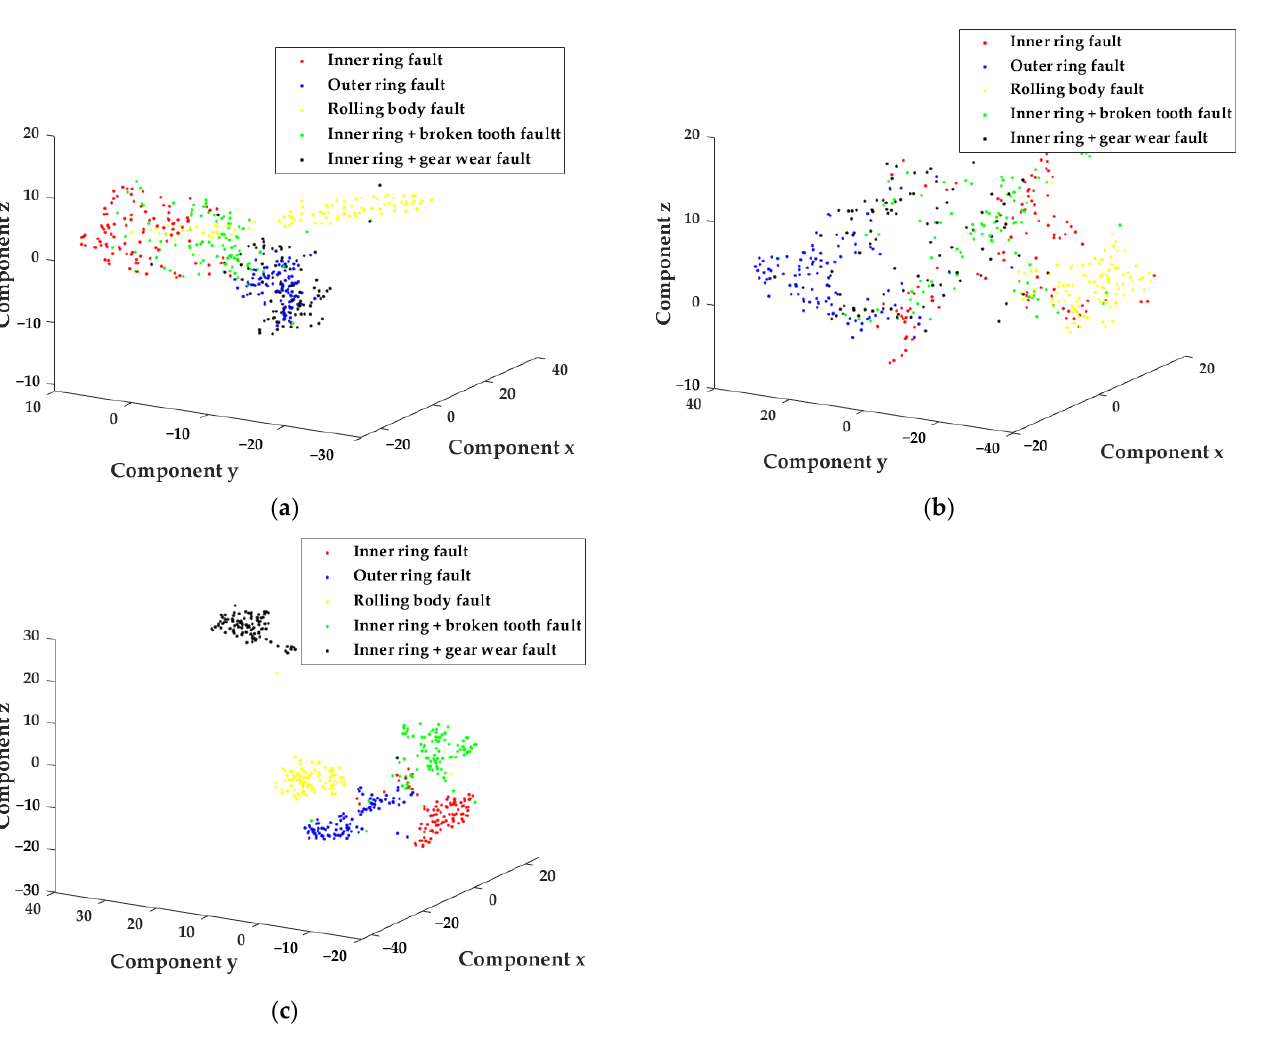
Figure 7. T-SNE dimensional reduction visualization of MFE feature set. ( a ) EEMD-PSO-MFE feature set. ( b ) LMD-PSO-MFE feature set. ( c ) AVMD-PSO-MFE feature set.